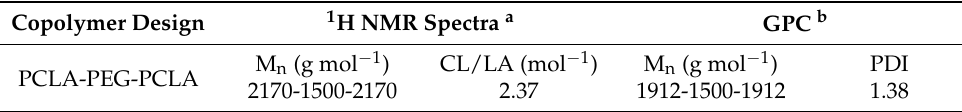
Figure 2. 1 H NMR spectra of ( A ) PCLA and ( B ) PCLA-Ac copolymer. ( C ) GPC trace of PCLA copolymer. ( D ) FT-IR spectra of PCLA copolymer. Table 1. Physicochemical characteristics of PCLA copolymer.